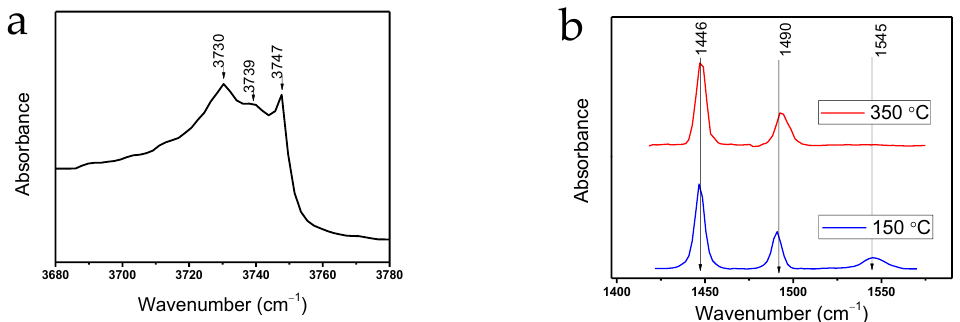
Figure 4. FTIR spectra of 5%Zr-SBA-15 ( a ) before pyridine adsorption, ( b ) desorption of pyridine at 150 and 350 °C. Varying the pyridine desorption temperature makes it possible to differ acid sites of different strengths. At 150 °C, pyridine is remained adsorbed on both weak and strong acid sites; with desorption temperature increase to 350 °C, pyridine is retained only on strong sites. After the pyridine desorption at 150 °C, absorption bands are observed at 1446, 1490, and 1545 cm −1 . The 1545 cm −1 band corresponds to the adsorption of pyridine on Bronsted acid sites (BAS) (PyH + ), the absorption band at 1446 – 1448 cm −1 corresponds